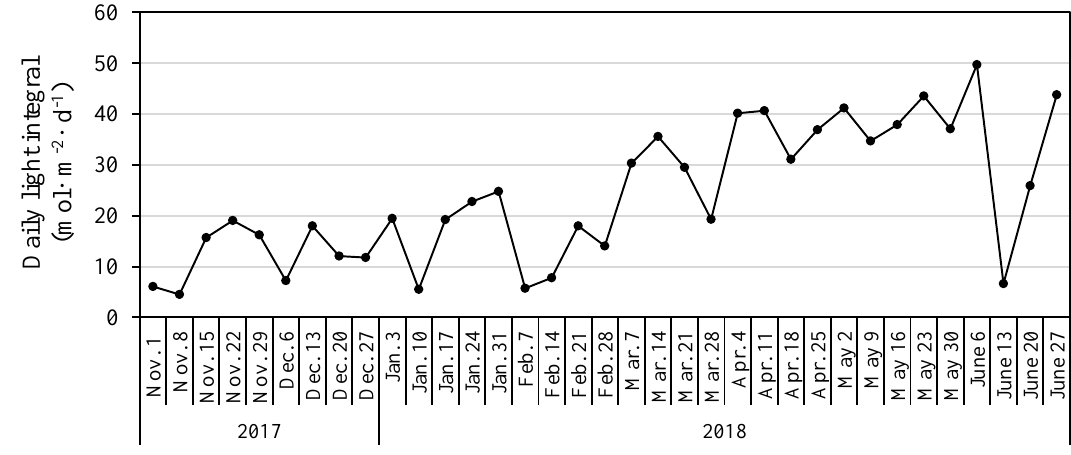
Figure 3. Daily light integral (DLI) in the high tunnel from November 2017 to June 2018 in Starkville, Mississippi. Daily light integral in the high tunnel was calculated by averaging photosynthetically active radiation ( PAR ) readings during a day and multiplying by 0.0864. PAR was recorded using a quantum sensor (HOBO S-LIA-M003; Onset Computer Corp.) at 15 min intervals connected to a data logger (HOBO Micro Station H21-002; Onset Computer Corp.).